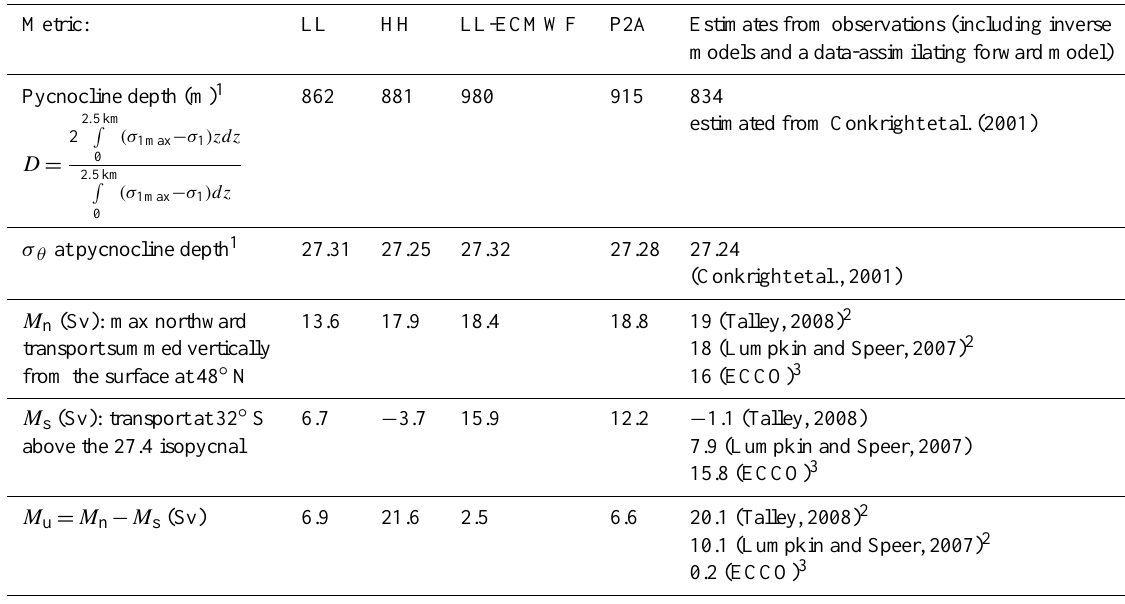
Table 2. Comparison of the pycnocline and MOC characteristics of the four models from the MOM3 suite and with estimates from observa- tions.